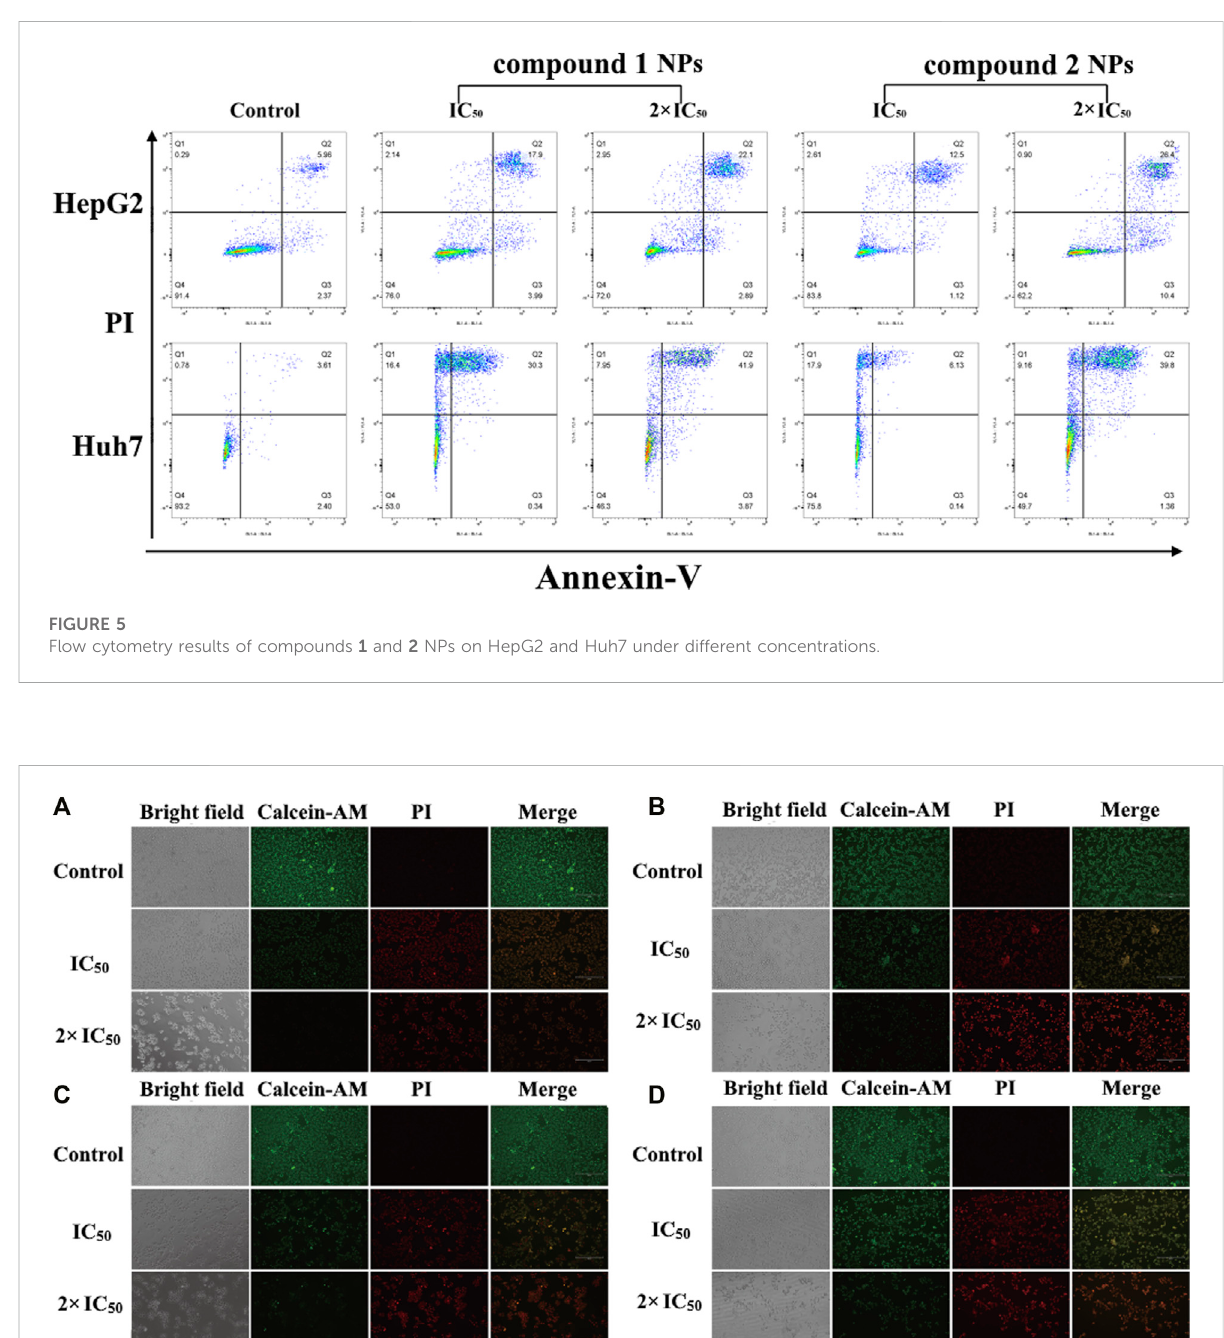
FIGURE 6 In vitro calcein AM and PI co-staining with compound 1 NPs (A) HepG2 cells and (B) Huh7 cells. Compound 2 NPs (C) HepG2 cells and (D) Huh7 cells.